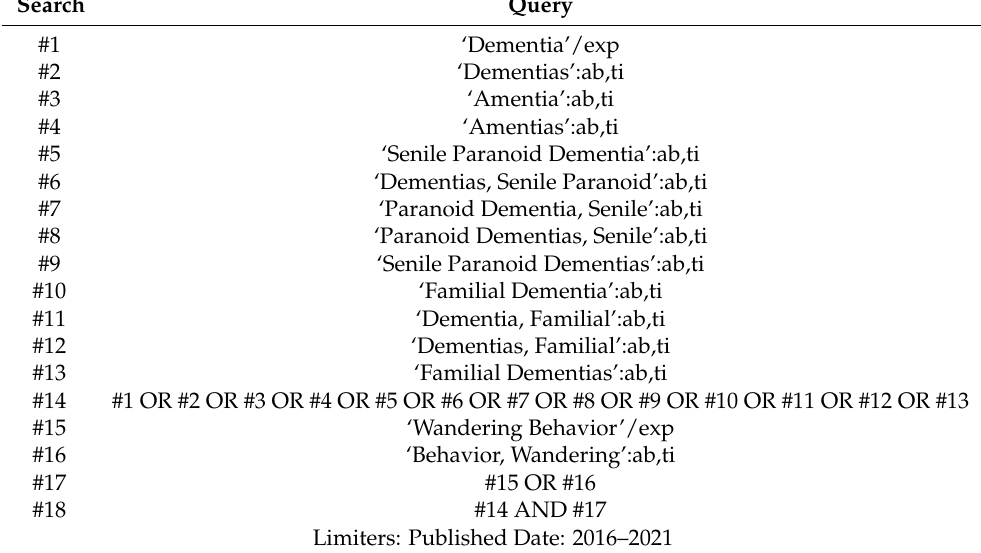
Table A3. Embase search